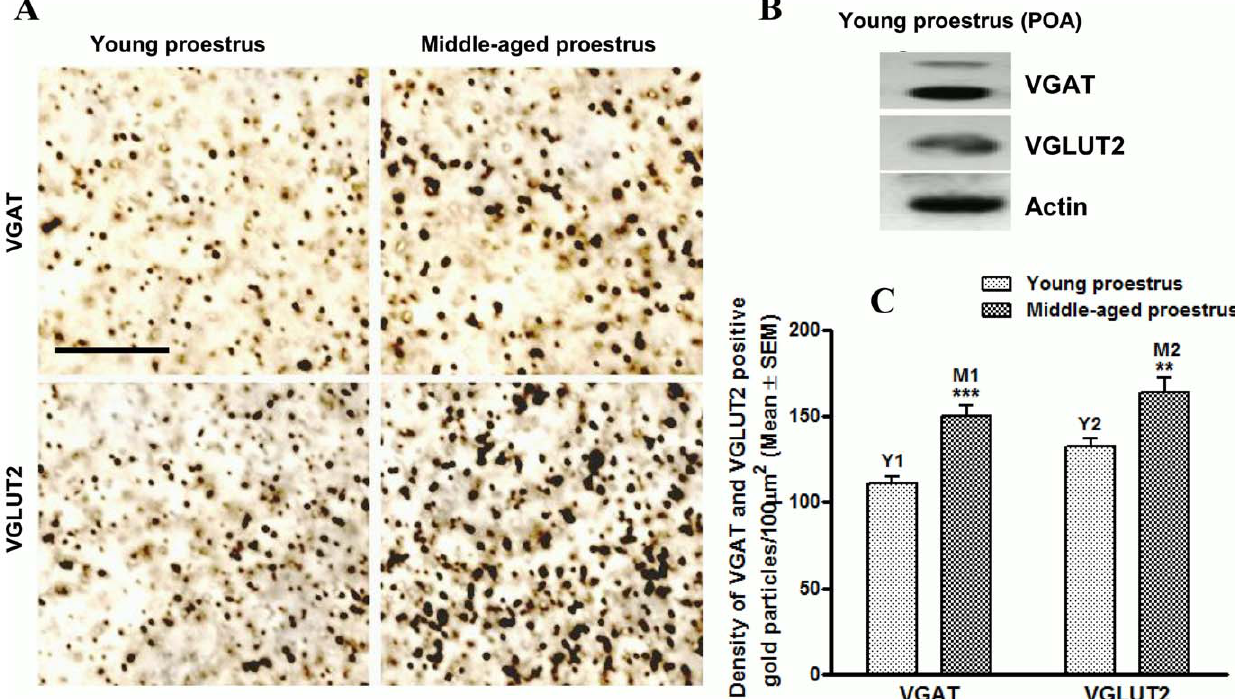
Figure 4. Measurement of VGAT and VGLUT2 terminals in rPOA by immuno-gold labeling. Figure 4A, shows silver-enhanced immuno- gold labeling of VGAT and VGLUT2 synaptic terminals from the rPOA of proestrus young and middle-aged animals. Figure 4B shows western blot detection of VGAT and VGLUT2 proteins from the POA of a young proestrus animal. Figure 4C shows statistical analysis of the density of VGAT and VGLUT2 positive gold particles from proestrous young and middle-aged animals, determined using Volocity4 . In middle-aged animals, mean density of both VGAT (Figure 4C, bar M1) and VGLUT2 (Figure 4C, bar M2) labeled gold particles was significantly higher ( P , 0.0001) compared to young animals (Figure 4C, bar Y1 for VGAT and bar Y2 for VGLUT2). Scale in Figure 4A represents 5 m